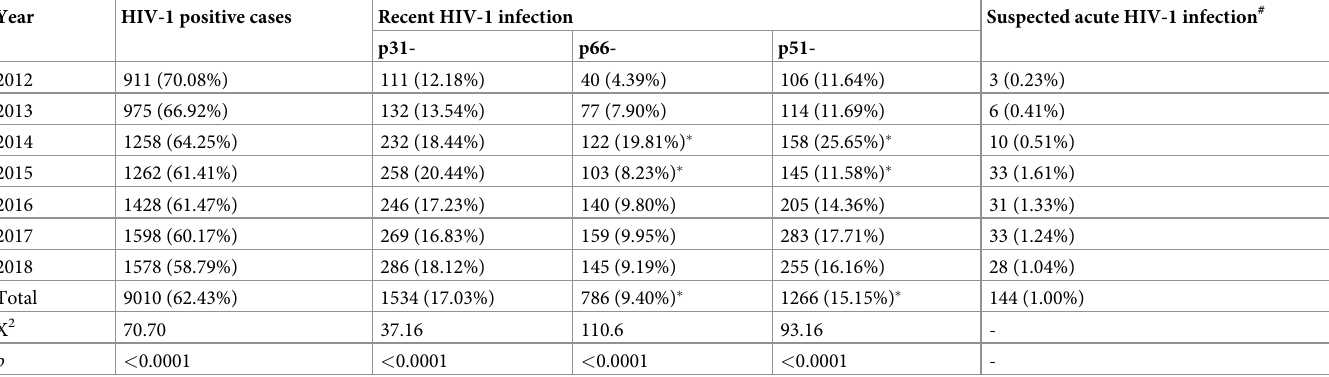
Table 2. Recent HIV-1 infection with the absence of band p31, p66, p51 and suspected acute HIV-1 infection in Wuhan city,